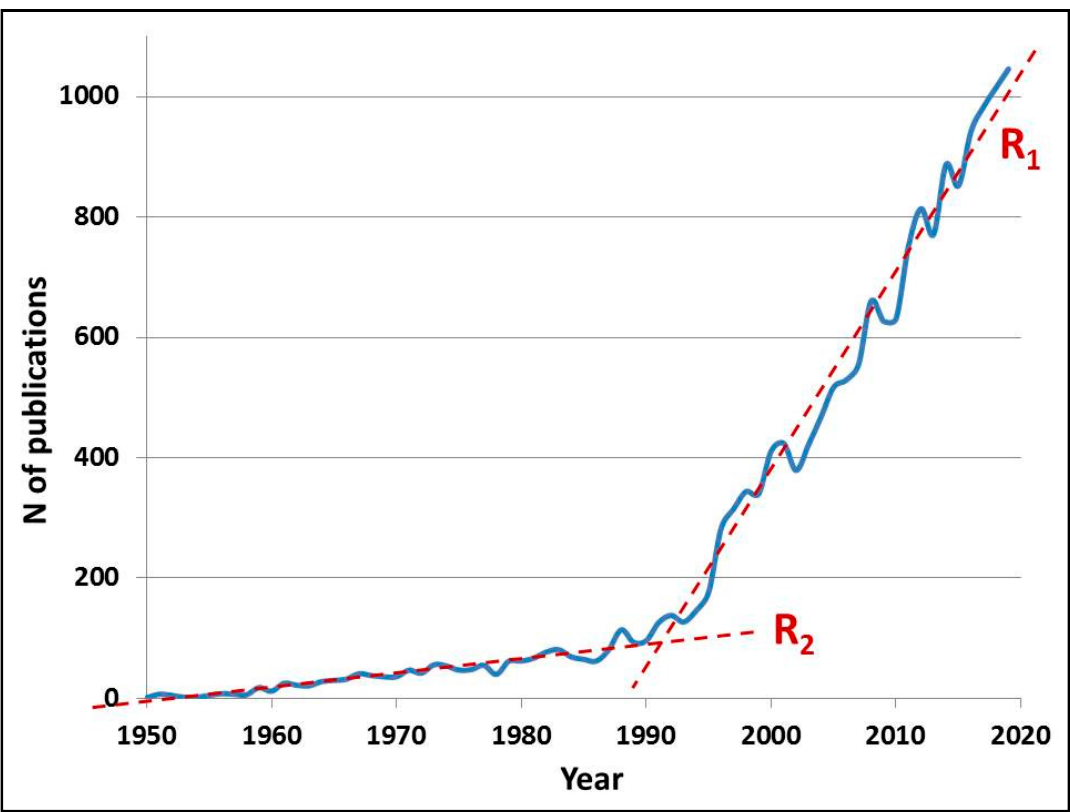
Figure 1. Trend of the number of publications per year on nematodes + plants from the years 1950–2019.